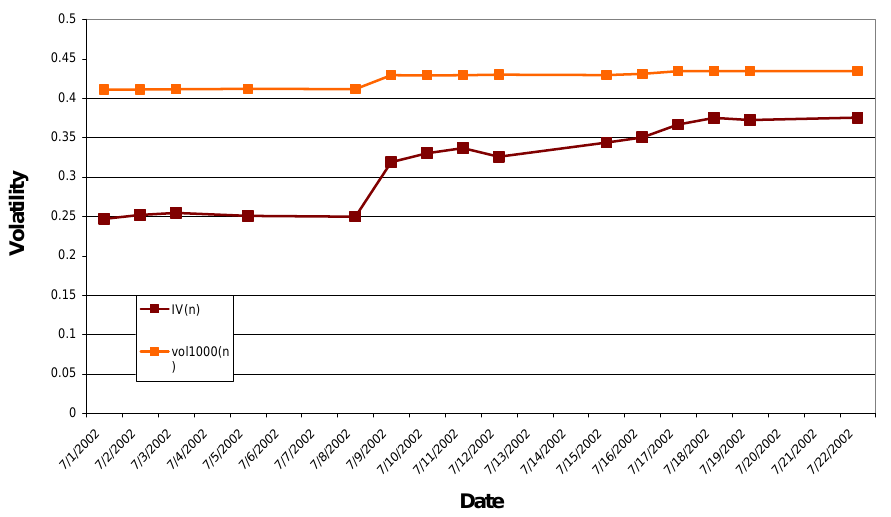
Figure 5. Wyeth, Bad News, Implied Vol. vs. Historical Vol. Figure 5 shows the dynamics of option-implied volatility and historical volatility in the period between 1 July and 23 July 2002. Option-implied volatility gives a much clearer signal than historical volatility on 9 July 2008. Both volatilities stay flat before 9 July 2008. On 9 July 2008, option-implied volatility jumps up at a much larger margin than historical volatility.